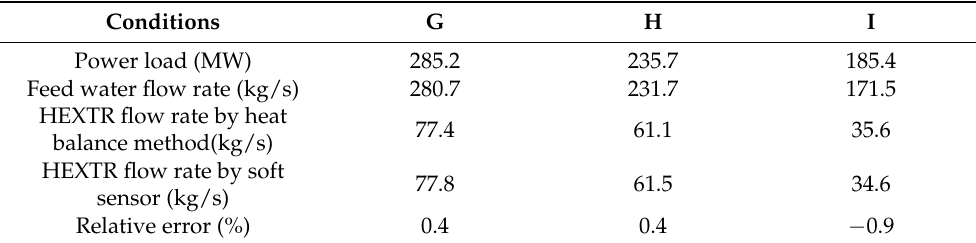
Table 2. Static error of soft sensor under experiment operation conditions.